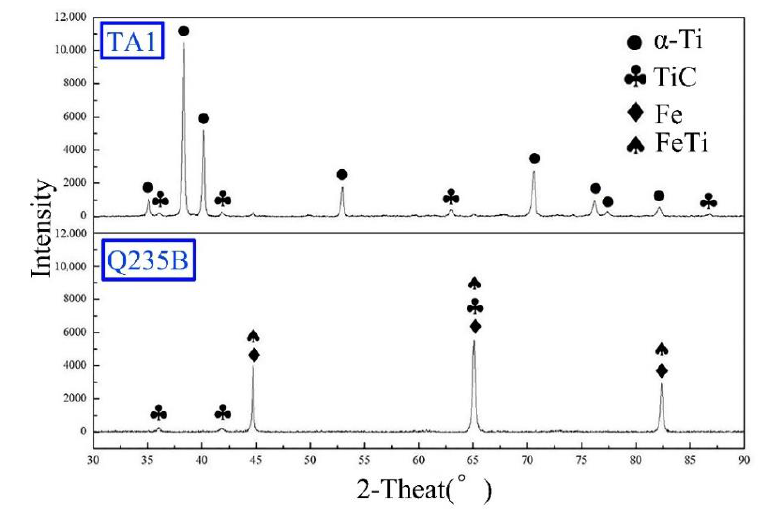
Figure 7. XRD patterns of both separation surfaces of TA1 / Q235B hot rolled sheet.